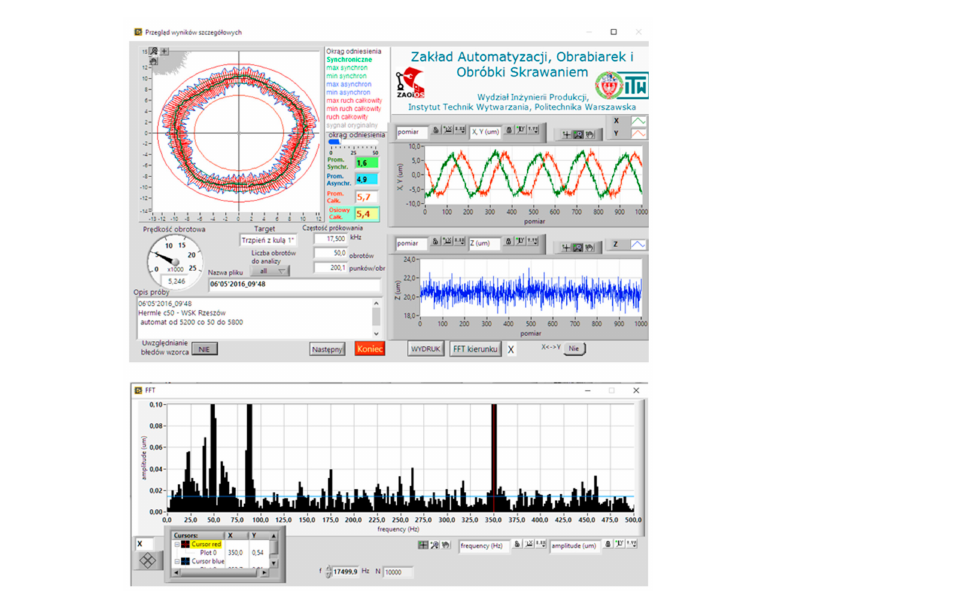
Figure 71. View of the detailed results screen for a specific spindle rotational speed with the FFT plot of the X axis direction.